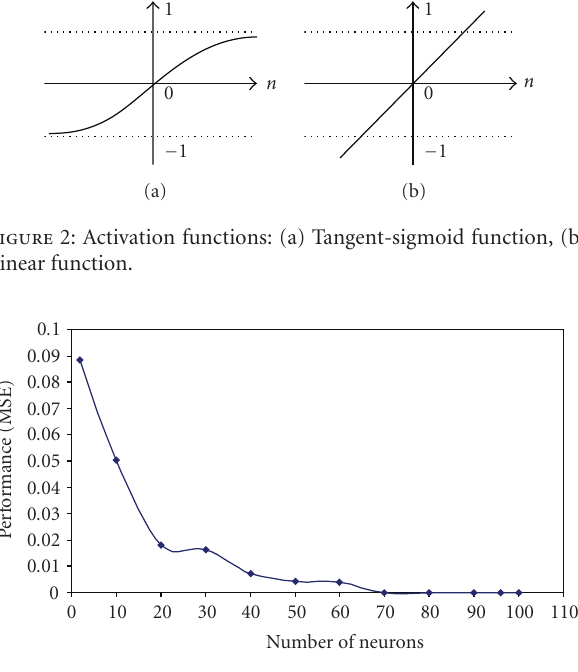
Figure 3: Evaluation of the number of neurons in the first hidden layer with neural network performance using MSE.